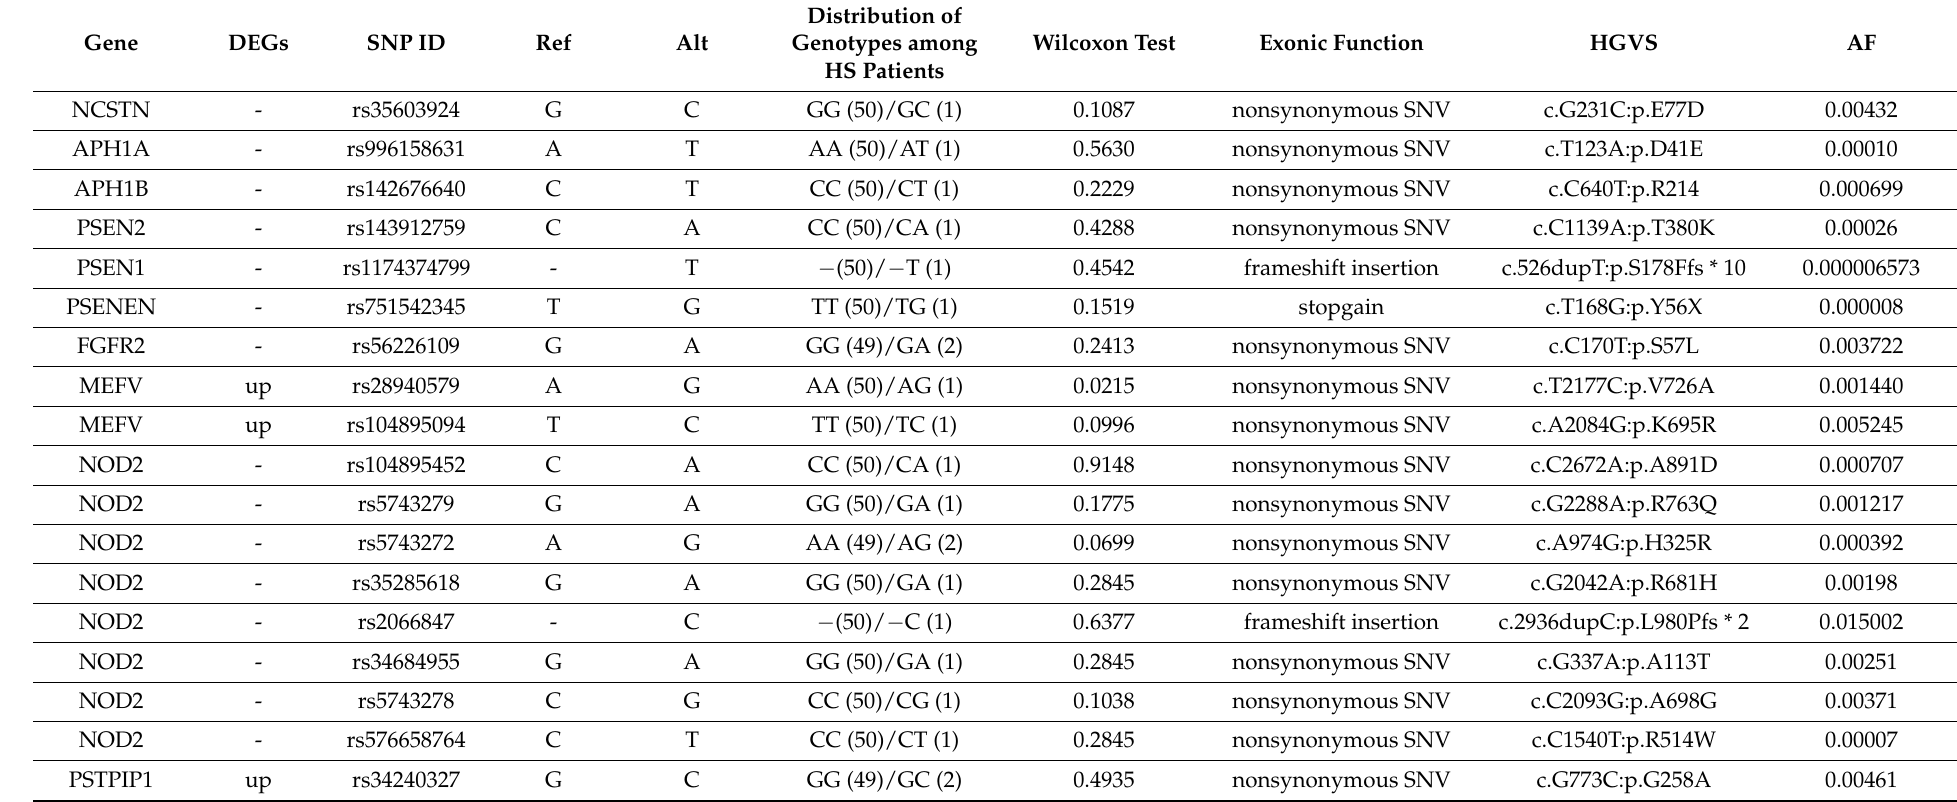
Table 3. Distribution of potential pathogenic variants with AF ≤ 0.01 among genes that have been already associated with